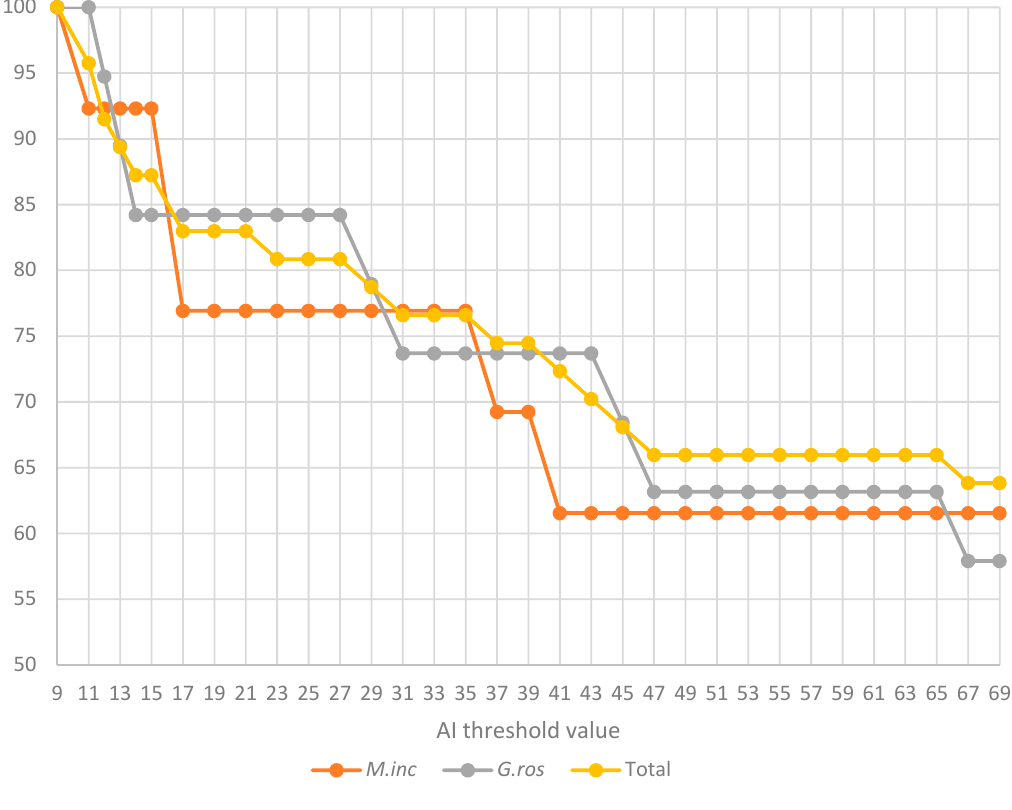
Figure 6. Phylogenetically supported HGT from the literature in the genomes of two plant-parasitic nematodes at different AI thresholds. Percentage of known and phylogenetically supported HGT cases ( y -axis) at different AI thresholds ( x -axis) in M. incognita (orange) and G. rostochiensis (grey).